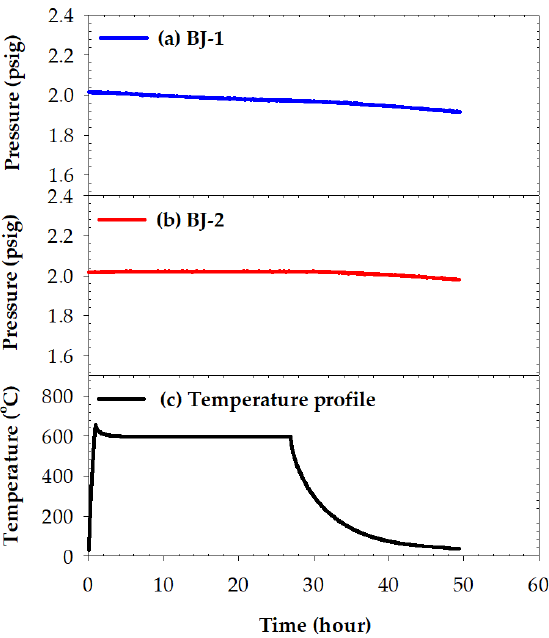
Figure 11. Pressure drops in leak tests of two joints tested at 600 °C for 24 h: ( a ) BJ-1, ( b ) BJ-2, and ( c ) temperature profile in the test.